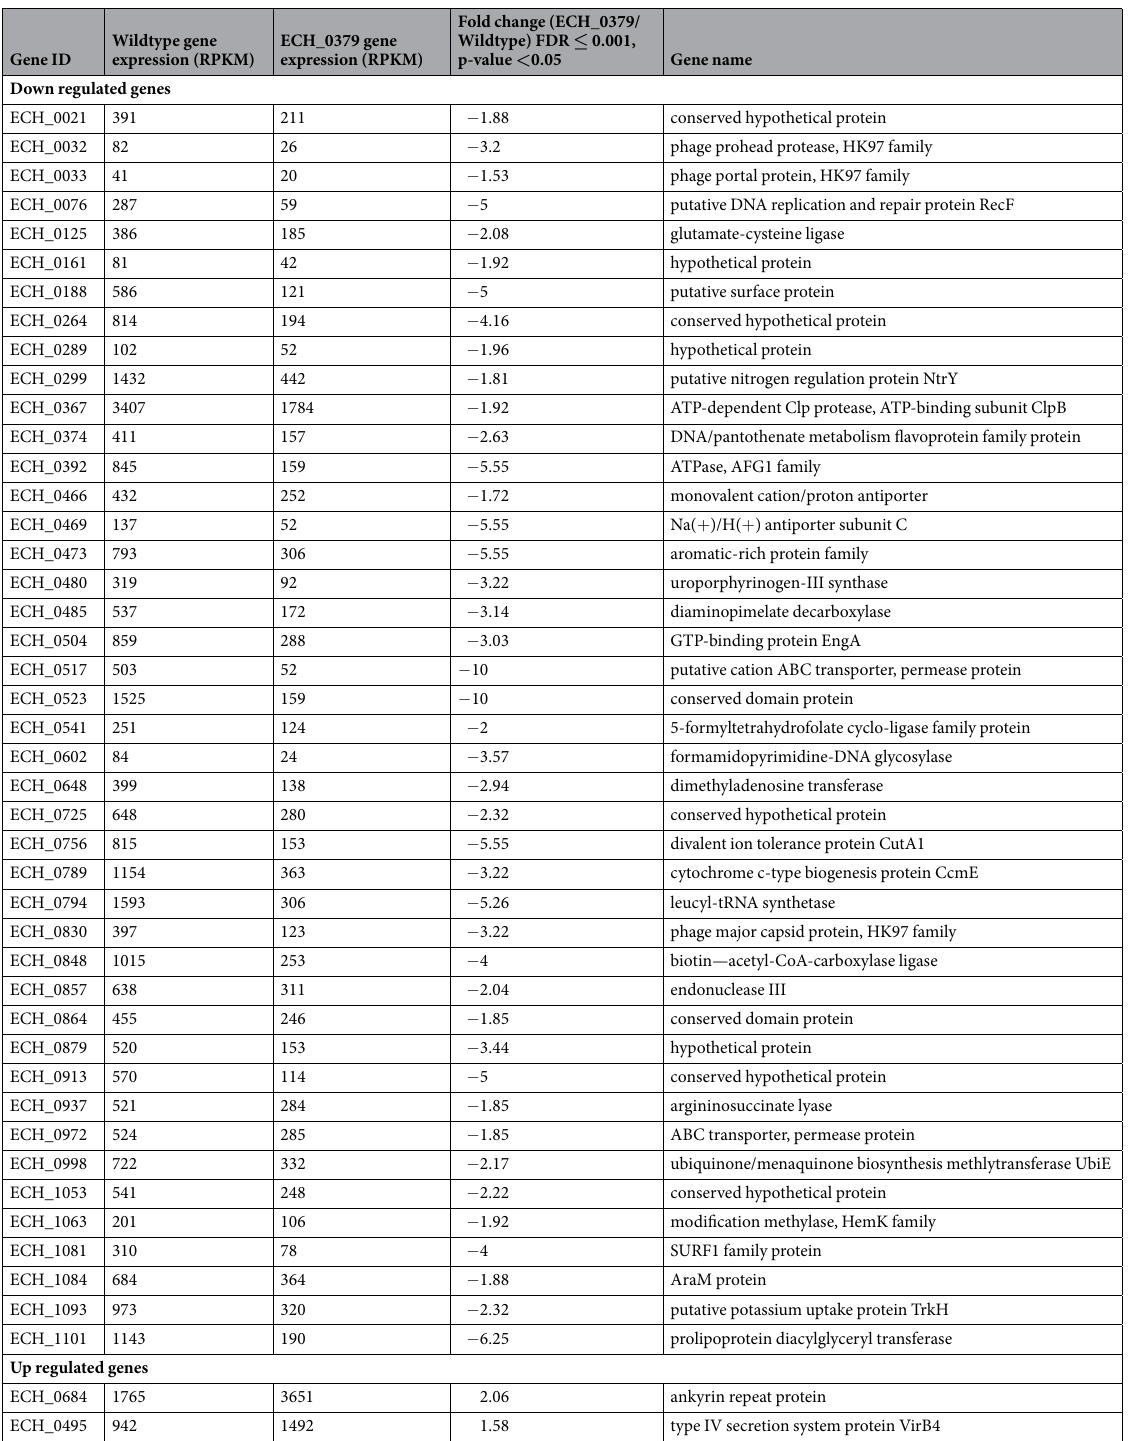
Table 2. E . chaffeensis genes differentially transcribed in ECH_0379 compared to